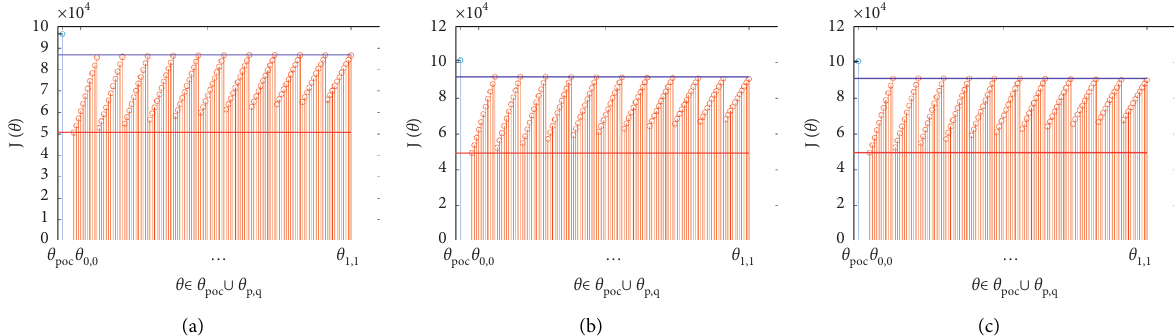
Figure 6: Comparison between optimal control strategy θ network, (b) e-mail network, and (c) Twitter network.